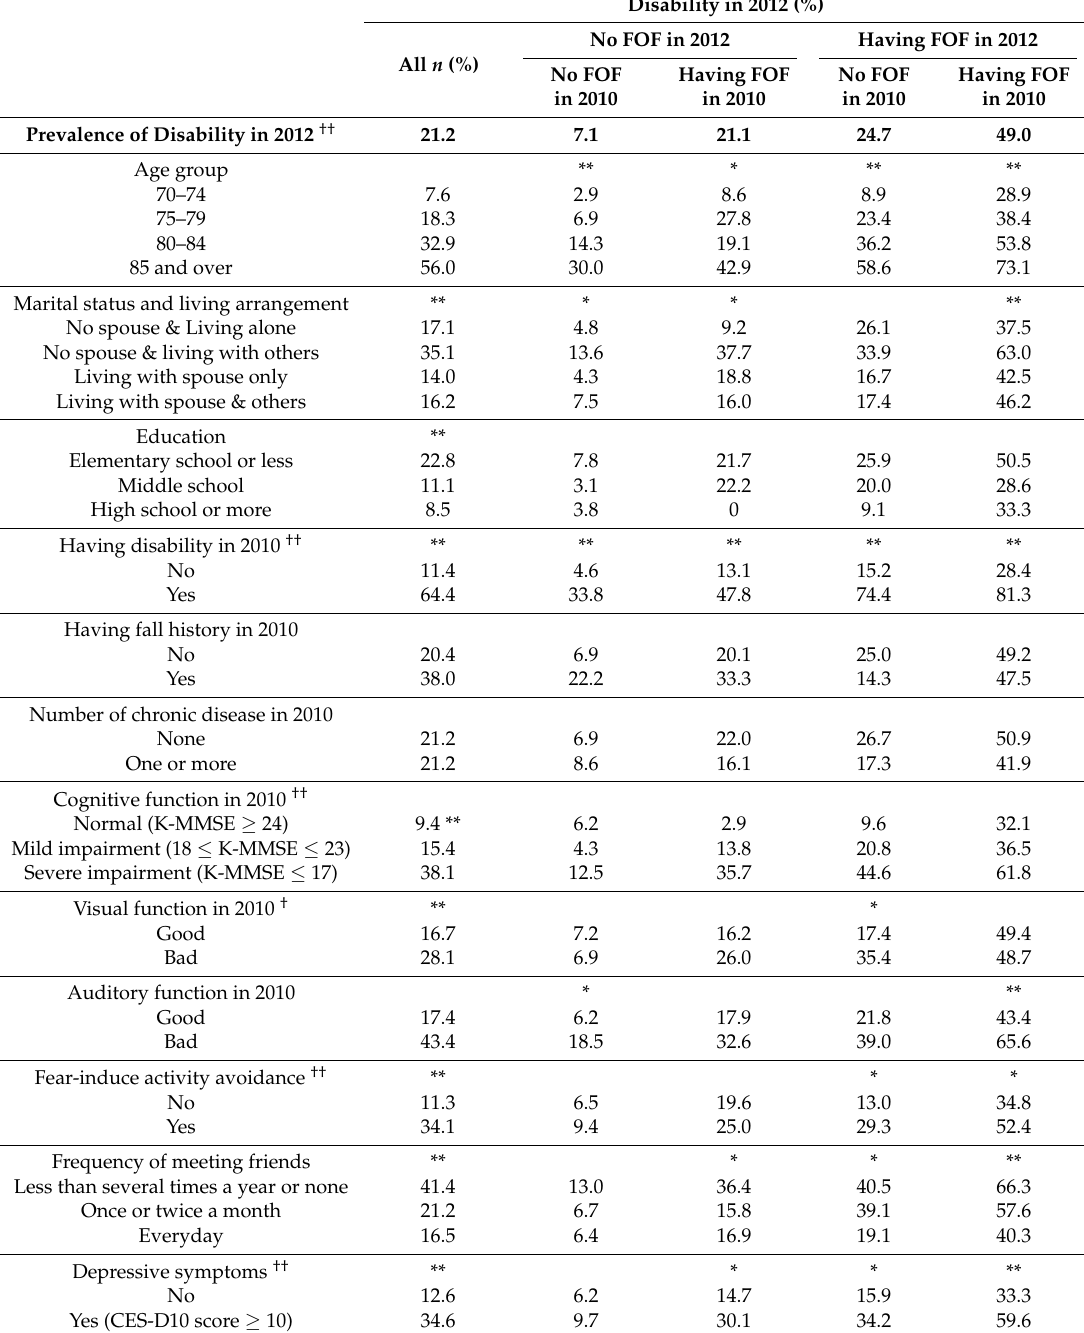
Table 2. The prevalence of disability in 2012 according to socio-demographic and health related characteristics among Korean older women aged 70 years or